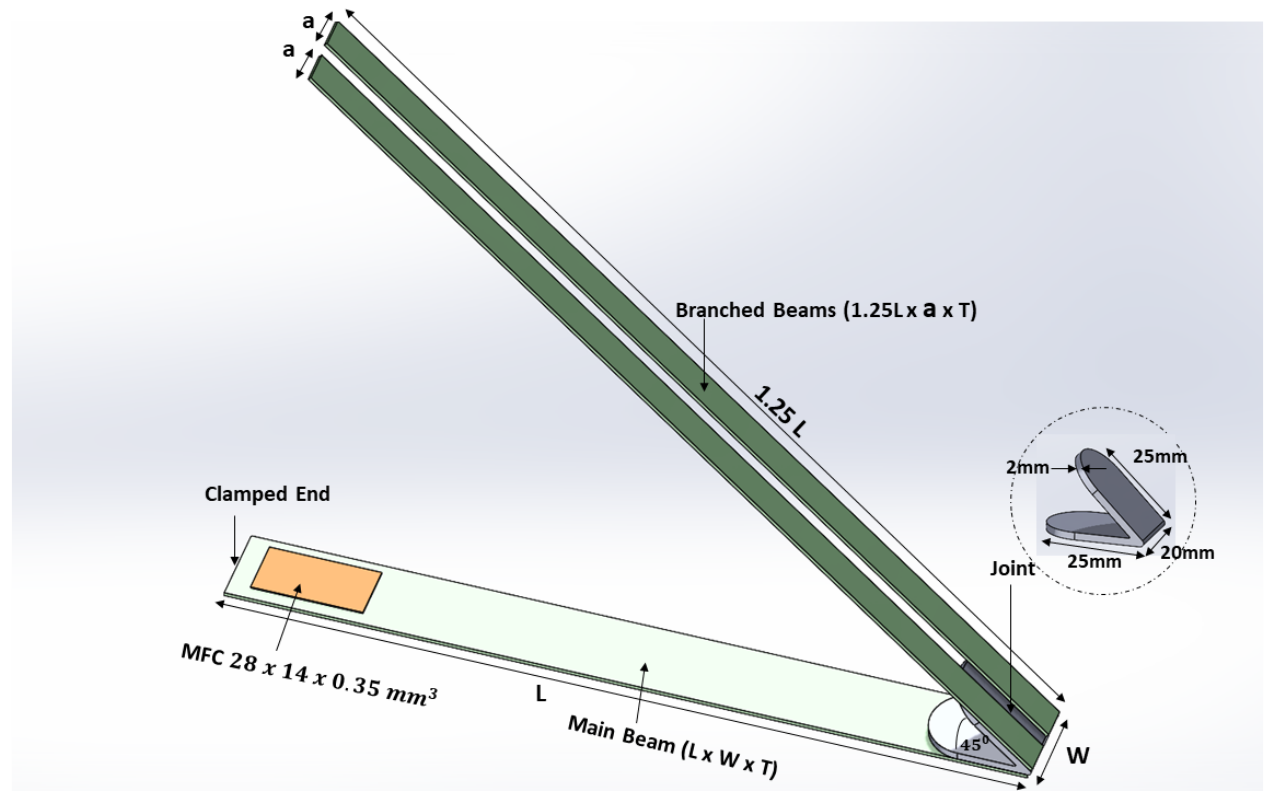
Figure 1. Schematic of proposed BBBH.